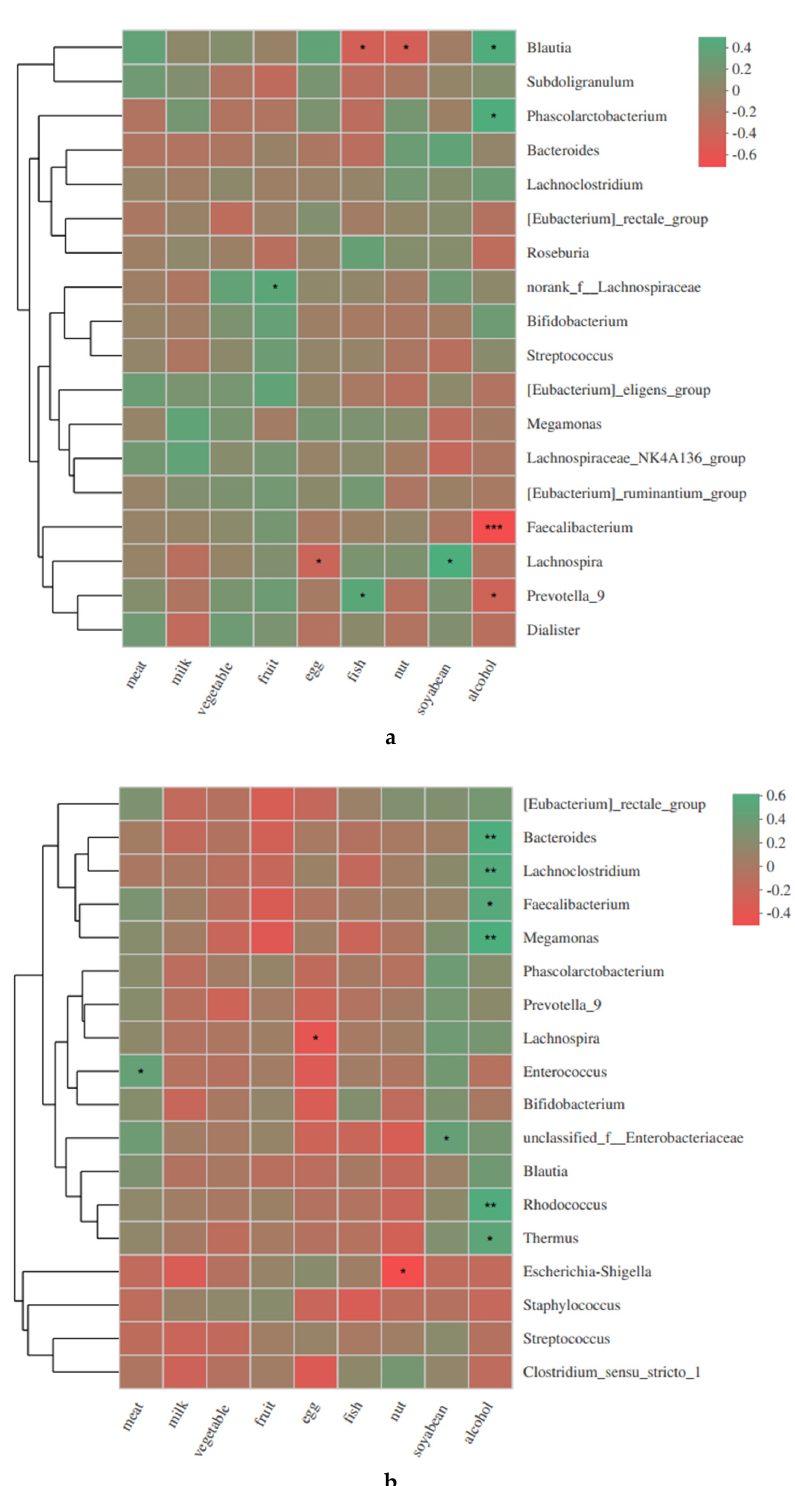
Figure 3. Relationship heatmap was performed to show the association between maternal/newborns’ bacterial abundance and maternal diet intake frequency as well as alcohol consumption before delivery. The coefficient appeared color-coded based on under (red) or over-representation (green) in the analysis (* 0.01 < p ≤ 0.05, ** 0.001 < p ≤ 0.01, *** p ≤ 0.001). ( a ) Indicates relationships among maternal gut microbiota with diet and alcohol consumption; ( b ) indicates relationships among newborns’ gut microbiota with maternal diet and alcohol